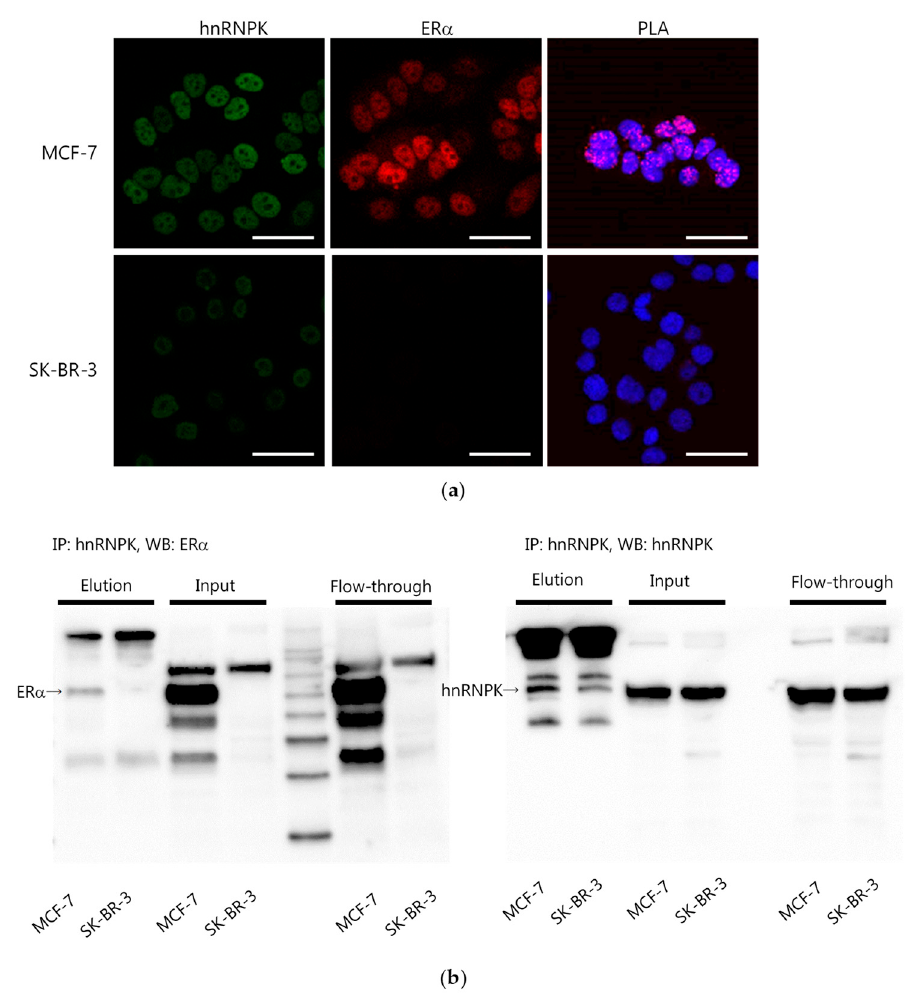
Figure 3. ER α and hnRNPK interaction. ( a ) Staining of hnRNPK and ER α using immunofluorescence (hnRNPK as green and ER α as red). Red dots (Texas red) indicate the interaction between hnRNPK and ER α detected using proximity ligation assay. Nuclei were stained blue (DAPI: 4 ′ -6-diamidino-2-phenylindole). Scale bar, 100 µm. ( b ) MCF-7 and SK-BR-3 cells were immunoprecipitated with anti-hnRNPK antibodies. After SDS-PAGE, ER α (65 kDa) and hnRNPK (65 kDa) expressions were detected using Western blotting analysis (WB). Different materials were used in Western blots: MCF-7 and SK-BR-3 cells (Input), unbound material (Flow-through), and eluted protein fraction (Elution).